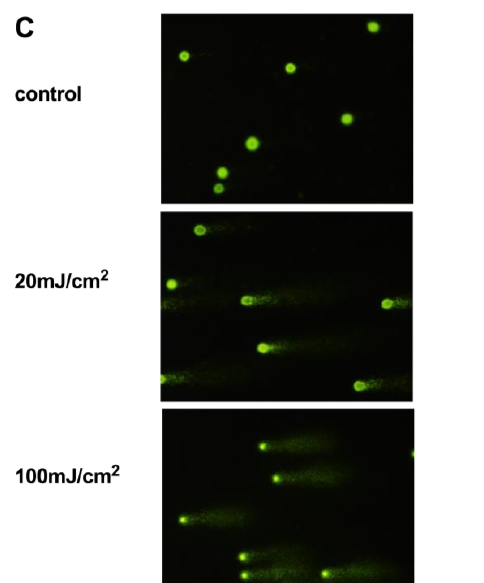
Figure 2. Comparison of the qPCR approach to the alkaline comet assay using peripheral blood mononuclear cells (PBMCs). Genotoxic stimulation with ultraviolet C (UVC; 20 or 100 mJ/cm 2 ) was assessed in freshly isolated PBMCs in ( A ) nDNA and ( B ) mtDNA by qPCR ( n = 9). DNA damage was also assessed after the same treatments using ( C ) the alkaline comet assay, and ( D ) median Olive tail moments were calculated for each slide ( n = 9). Results are presented as mean ± SE. *** p < 0.001, **** p < 0.0001.